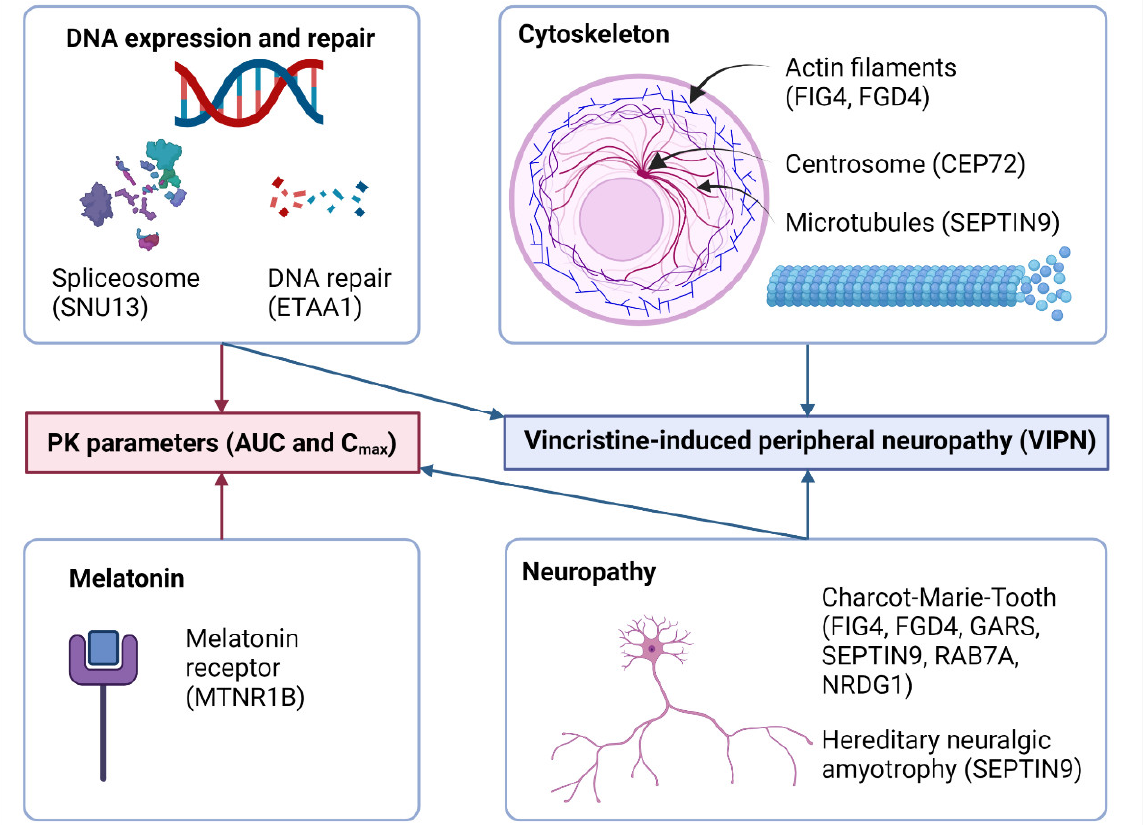
Figure 4. Schematic overview of the significant associations between genetic variations and VCR PK and VIPN. Figure created with Biorender.com.